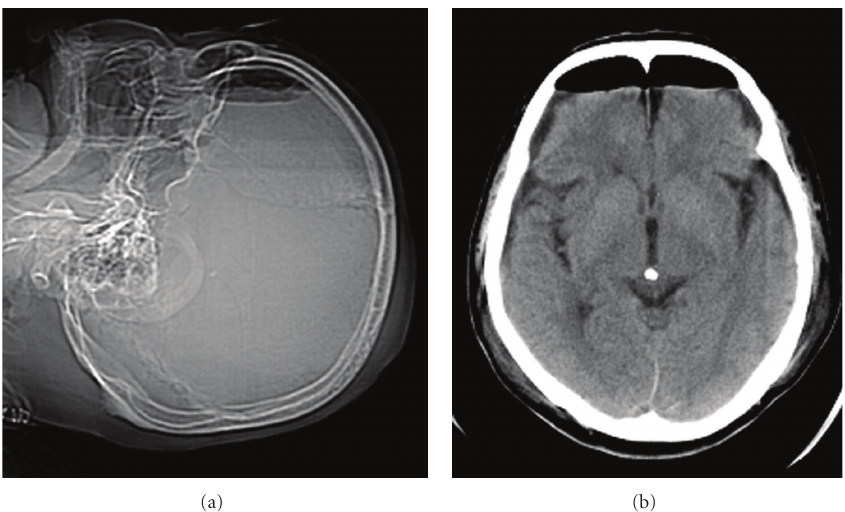
Figure 2: Head image ((a): Plain radiograph, (b): CT). (a) Plain radiograph demonstrates significant intracranial air. (b) CT reveals massive pneumocephalus involving the subarachnoid spaces. CT: Computed tomography.